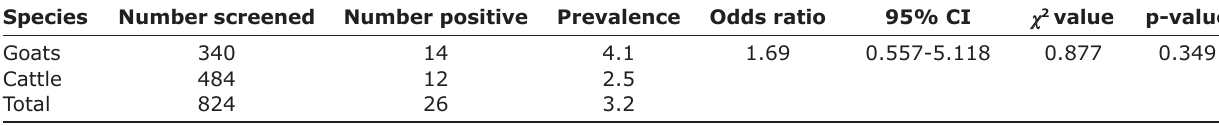
Table-1: Seroprevalence of Brucella antibody in cattle and goats slaughtered in Enugu State, Nigeria. Species